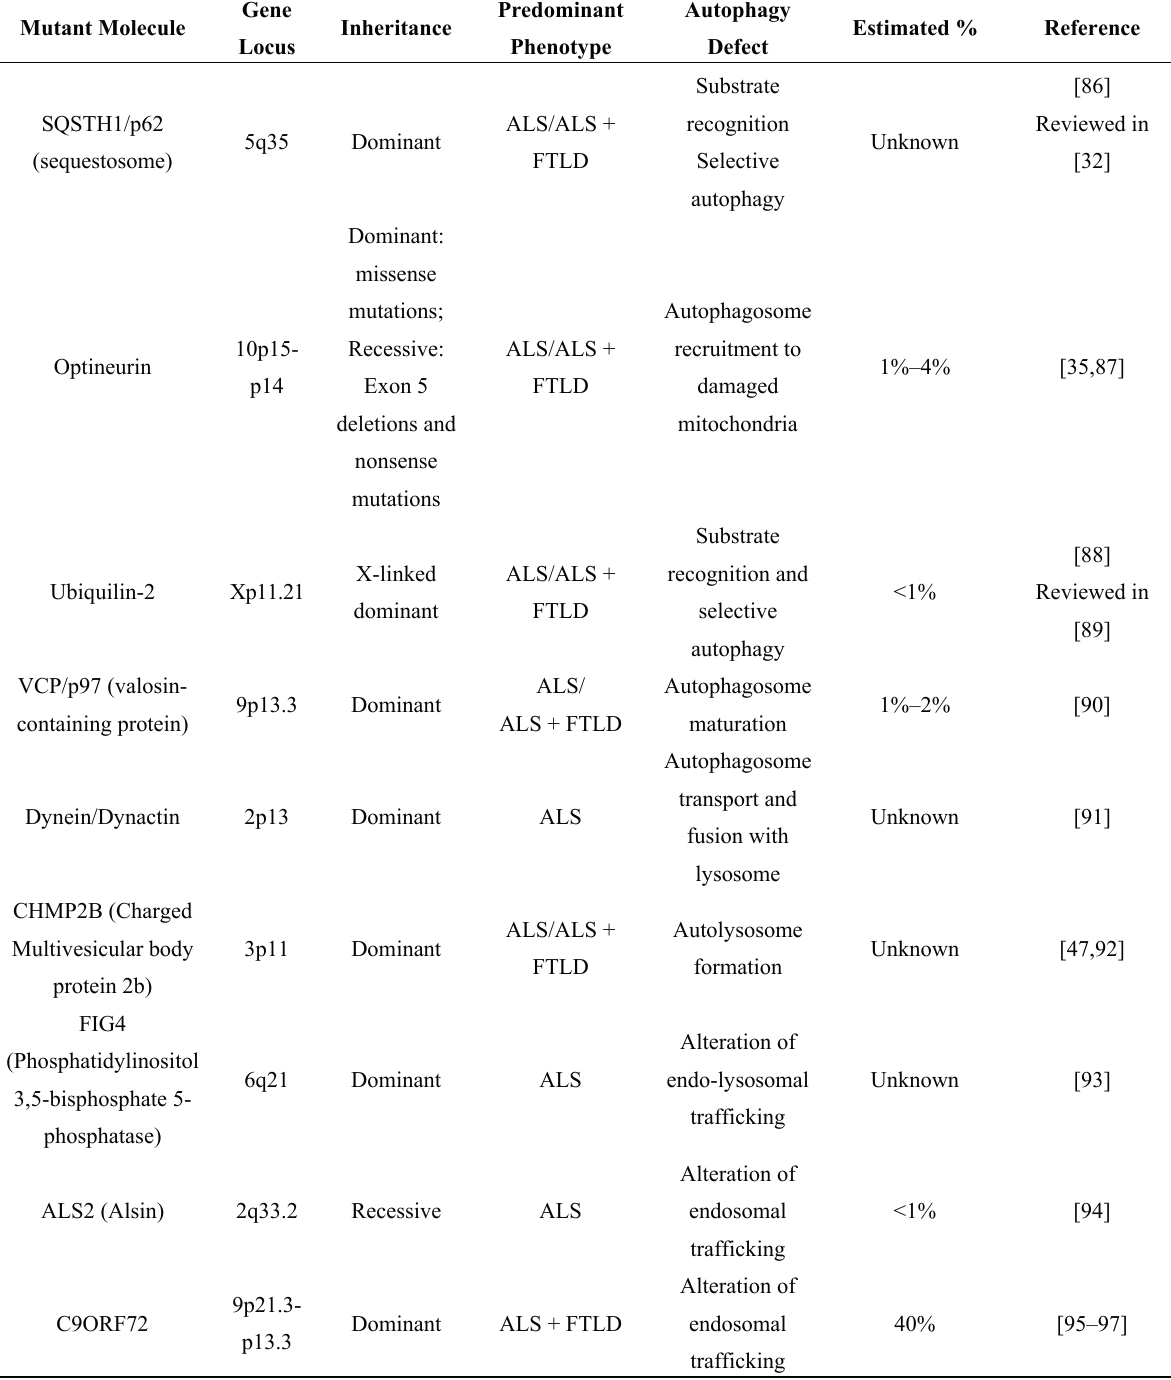
Table 1. Genetic causes of ALS associated with defective autophagy. Mutant